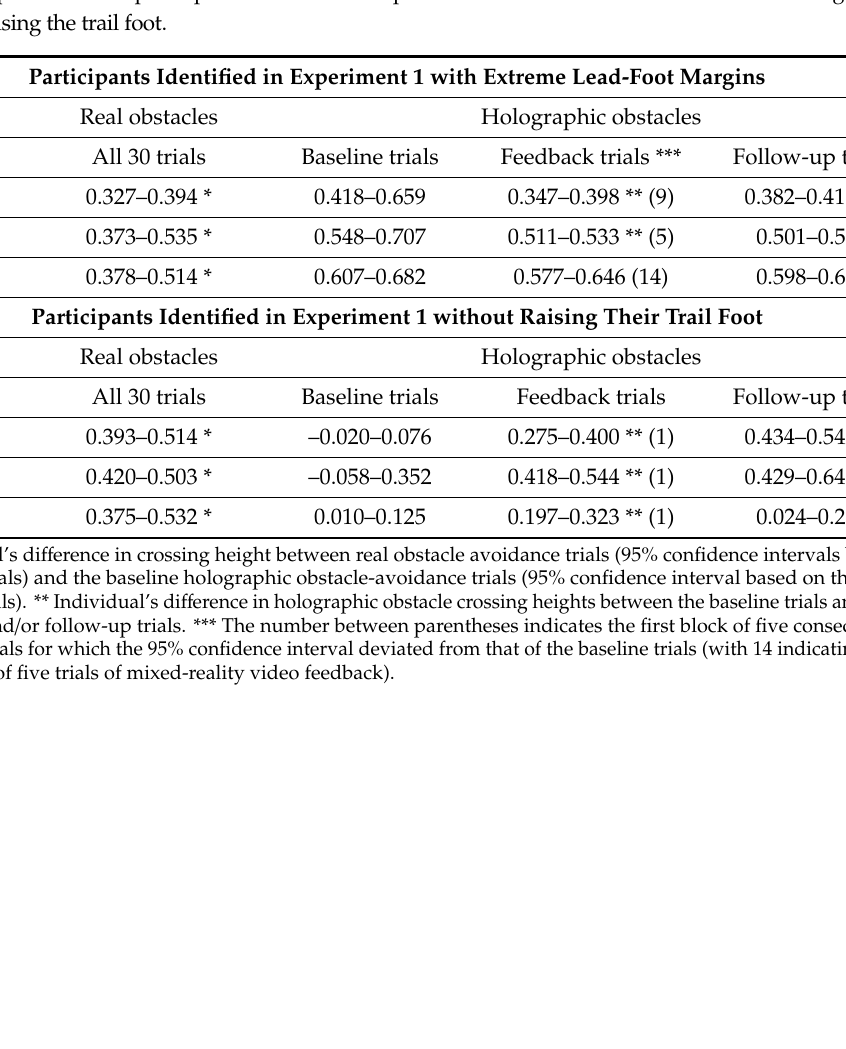
Table 1. Individual’s 95% confidence intervals of crossing heights of real and holographic obstacle-avoidance trials of Experiment 2 for participants identified in Experiment 1 as those with extreme lead-foot margins or without raising the trail